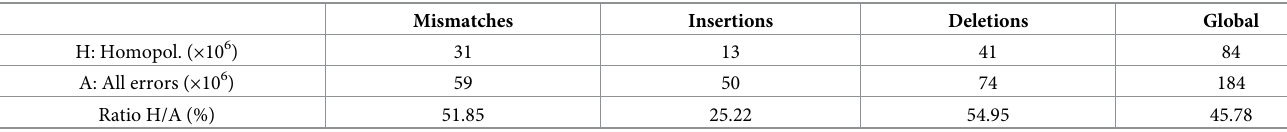
Table 3. Bacteria: Total and homopolymer-induced sequencing errors.